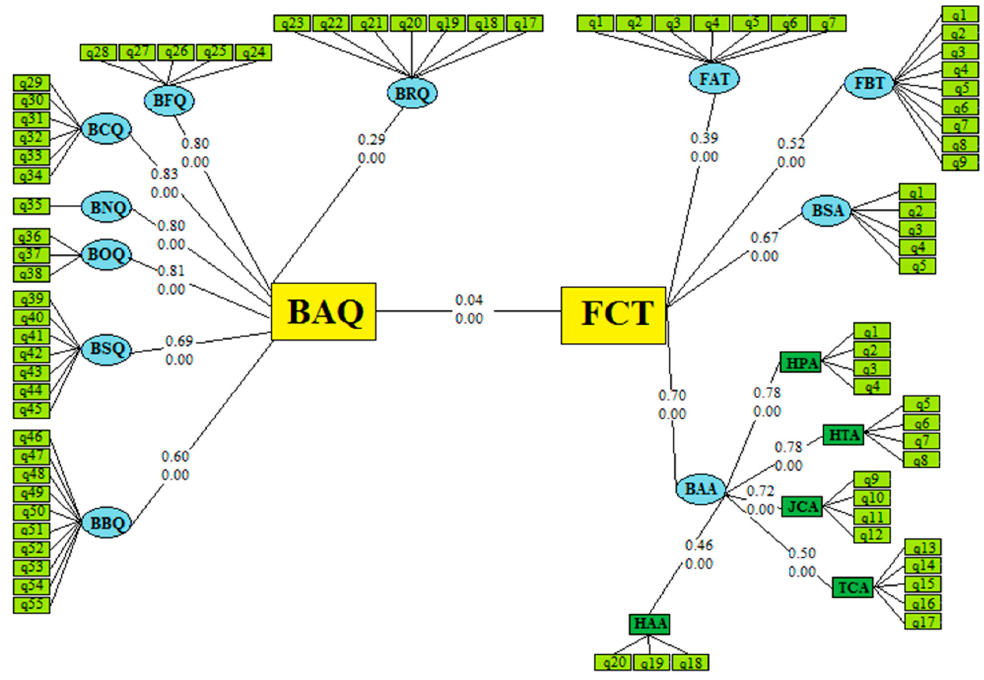
Figure 1. The effect of implicit and explicit variables on stock exchange data. Note: FCT is familiarity with blockchain technology (total questions); FAT is familiarity with blockchain technology, part 1; FBT is familiarity with blockchain technology, part 2; BAA is blockchain applications for accounting; HPA is hope (expectation of) to perform; HTA hopes to try; JCA is job communication; TCA is confidence; HAA is compatibility; BSA is blockchain applications for auditing; BAQ is quality of information (total questions); BRQ is relevance; BFQ is faithful representation; BCQ is comparability; BNQ is timeliness; BOQ is verifiability; BSQ is understandability; and BBQ is blockchain on the quality of